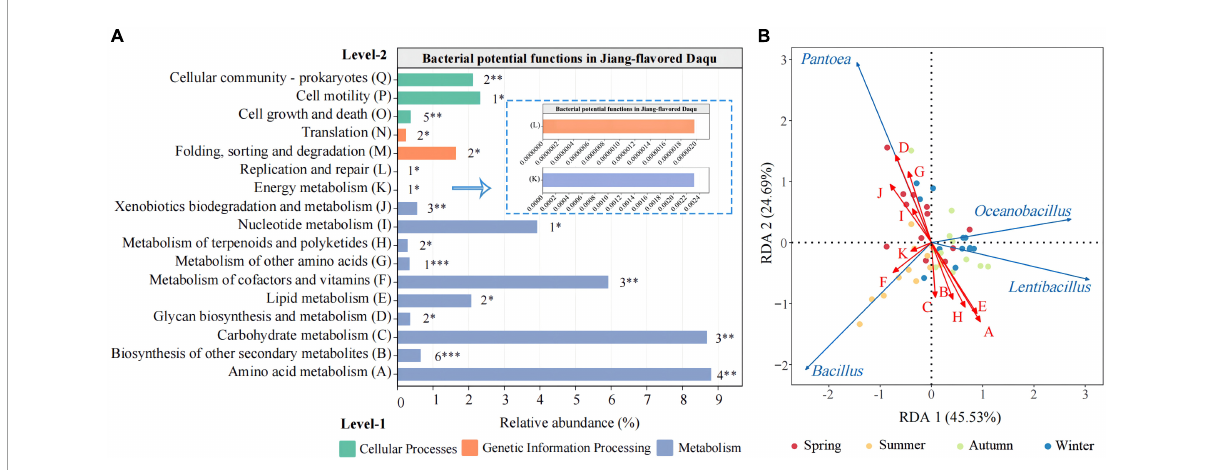
FIGURE5 An overview of the bacterial functions in Daqu predicted by PICRUSt2 based on 16S rRNA sequencing data (A) . RDA biplot displaying the relationship between the differential metabolic pathways and dominant bacterial genera (B) . Red letters represent differential metabolic pathways, and the blue arrows represent dominant bacterial genera. Significant difference is represented by *( P < 0.05), **(0.001 ≤ P < 0.01), ***( P <